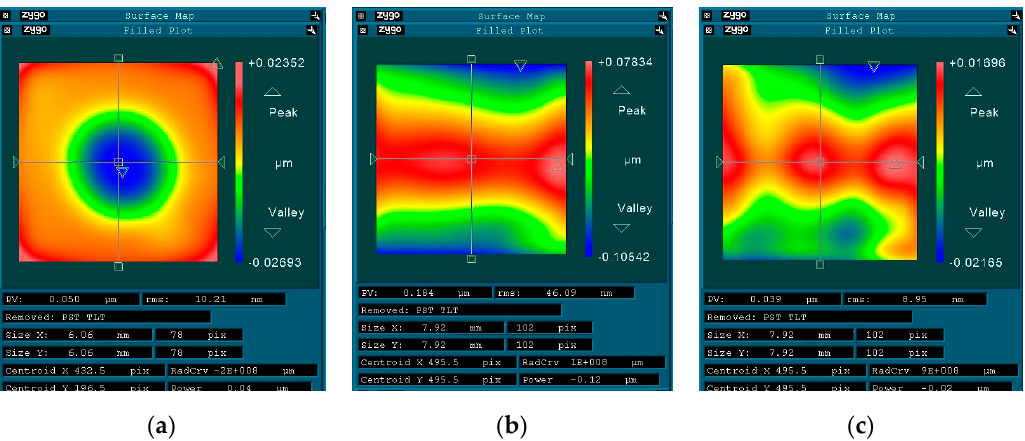
Figure 9. The 8 × 8 mm yttrium aluminum garnet Y3Al5O12 (YAG) plate 3D correction results—the VEH tool spot ( a ); the plate shape before correction ( b ); the plate shape after correction ( c ).